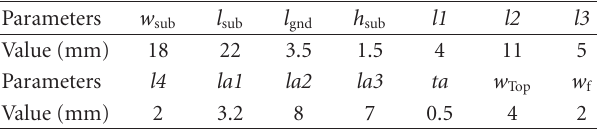
Figure 6: E ff ects of parameter lb on the 5.5 GHz band-notch function. Table 1: Optimized parameters of the single band-notched anten-